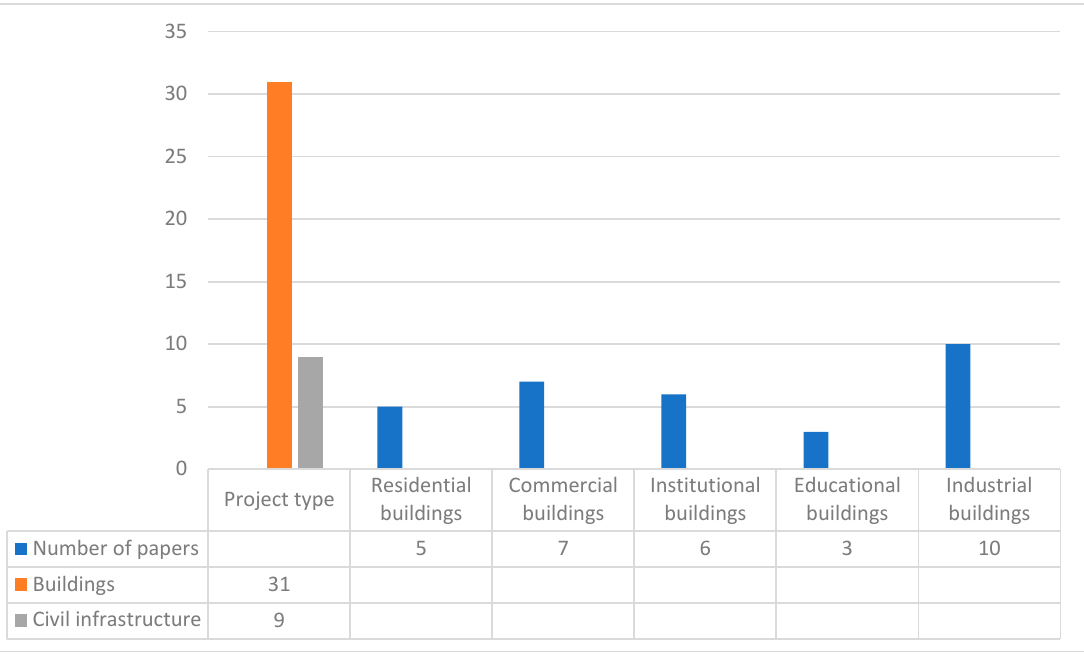
Figure 7. Categorisation of papers according to project and building types.